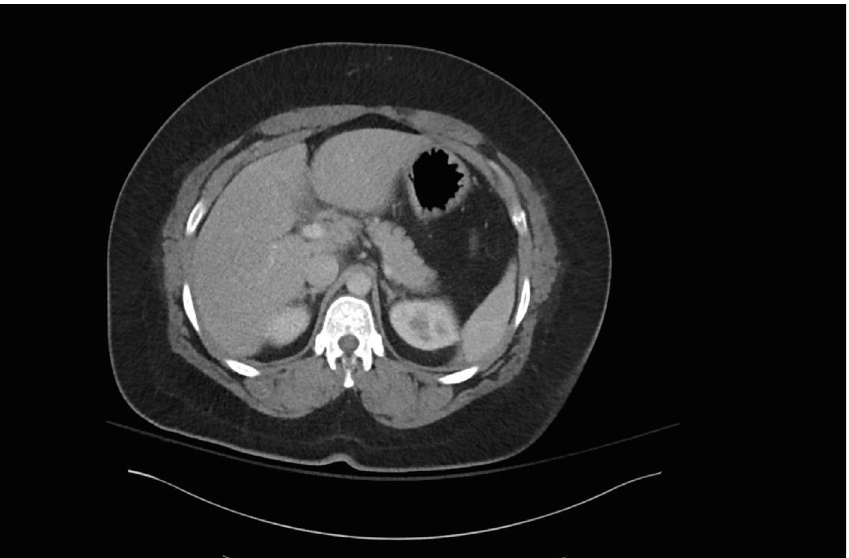
Figure 4: 35-Year-old female with biliary colic concerning for acute cholecystitis. Findings: contrast-enhanced CT images of the abdomen in the portal venous phase in the sagittal (1a), coronal (1b), and axial (1c) planes demonstrate empty gallbladder fossa. Technique: axial CT with sagittal and coronal reconstructions, 158 mA, 120 kV, 3mm slice thickness, and 80ml Omnipaque 350 intravenous